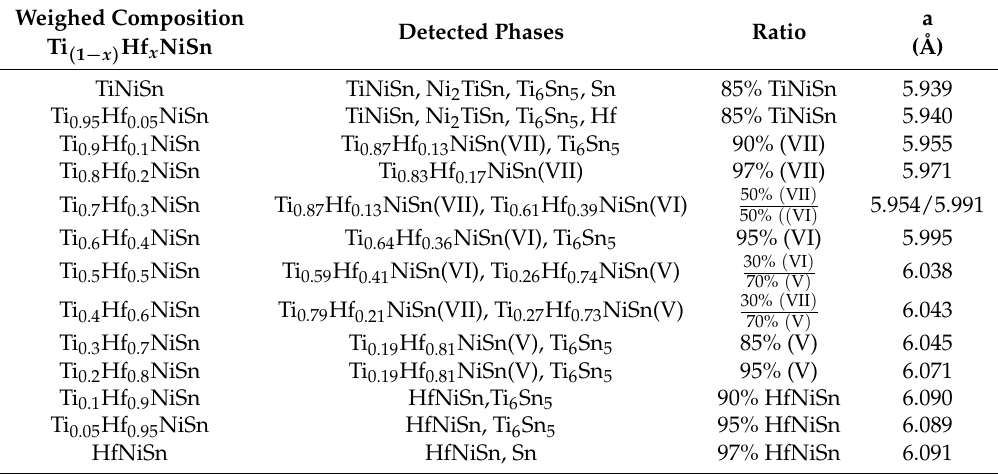
Figure 8. The Ti ( 1 − x ) Hf x NiSn series with the detected phases indicated in the Gibbs triangle. Table 5. The phase compositions of the different Ti ( 1 − x ) Hf x NiSn samples and the parent samples.